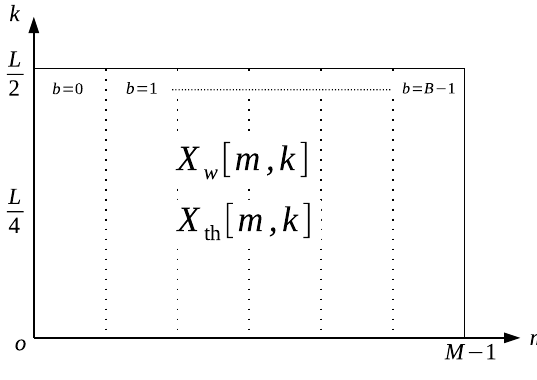
Figure 4. Definition of blocks in the time-space